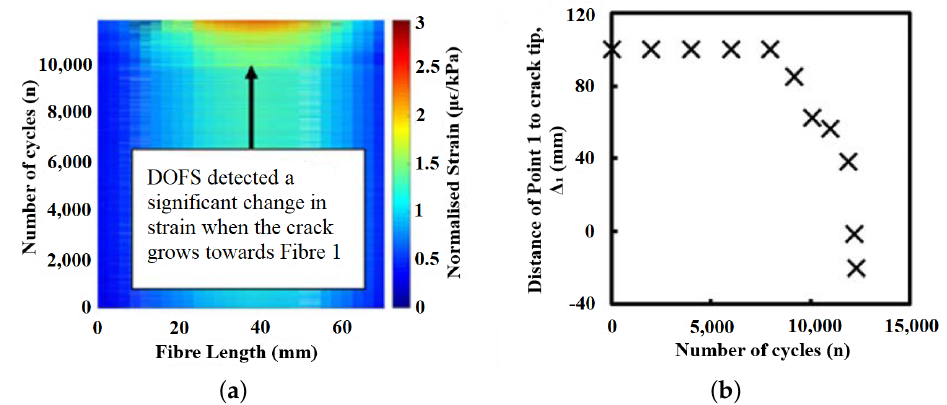
Figure 32. ( a ) The distributed strain measured along Fibre 1 during the cyclical pressure loading. ( b ) The relationship between the distance from the tip of the crack to Fibre 1 and the number of pressure loading cycles. Reprinted under Creative Commons CC BY-NC-ND license [115].